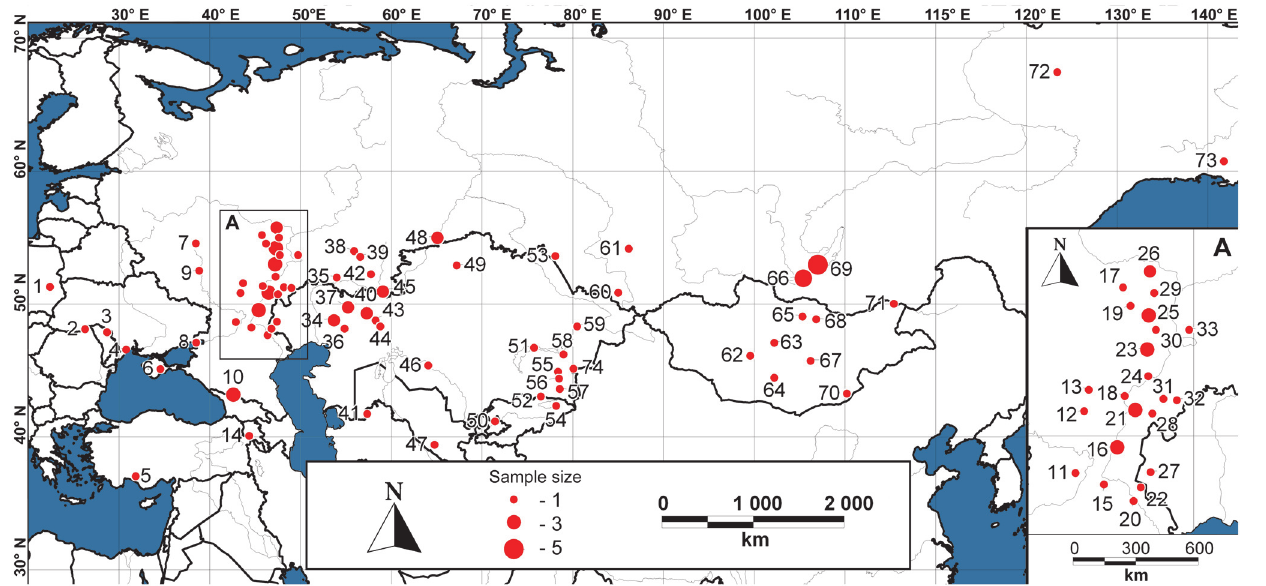
Figure 1. Map of the study area showing collection localities for this study (see S1 Table for locality